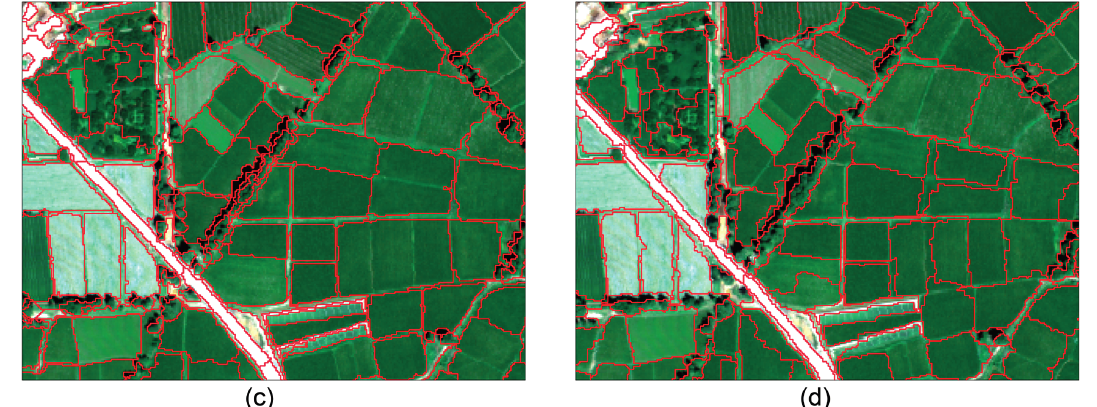
Figure 11. Image segmentation results of the three segmentation schemes. ( a ) VHR image of the sub-study area; ( b – d ) show the VHR-, VHR/CHM-, and MNF/CHM-based segmentation results.